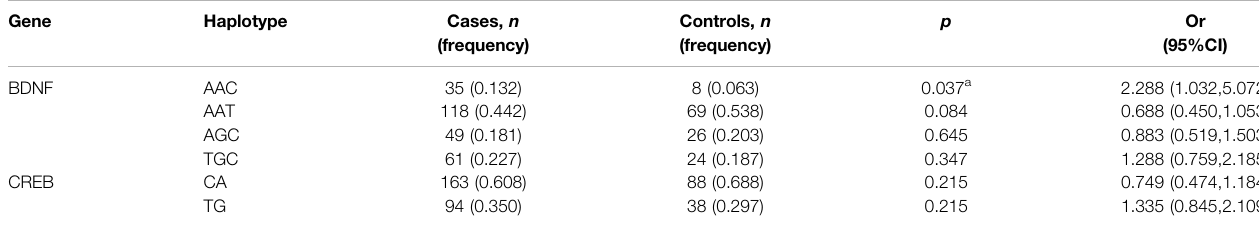
TABLE 8 | Analysis of haplotype distribution between the schizophrenia and control groups.